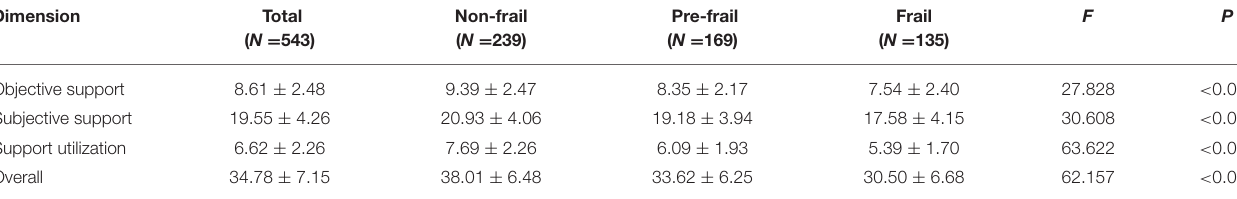
TABLE 2 | Social support of community-dwelling older adults according to the frailty